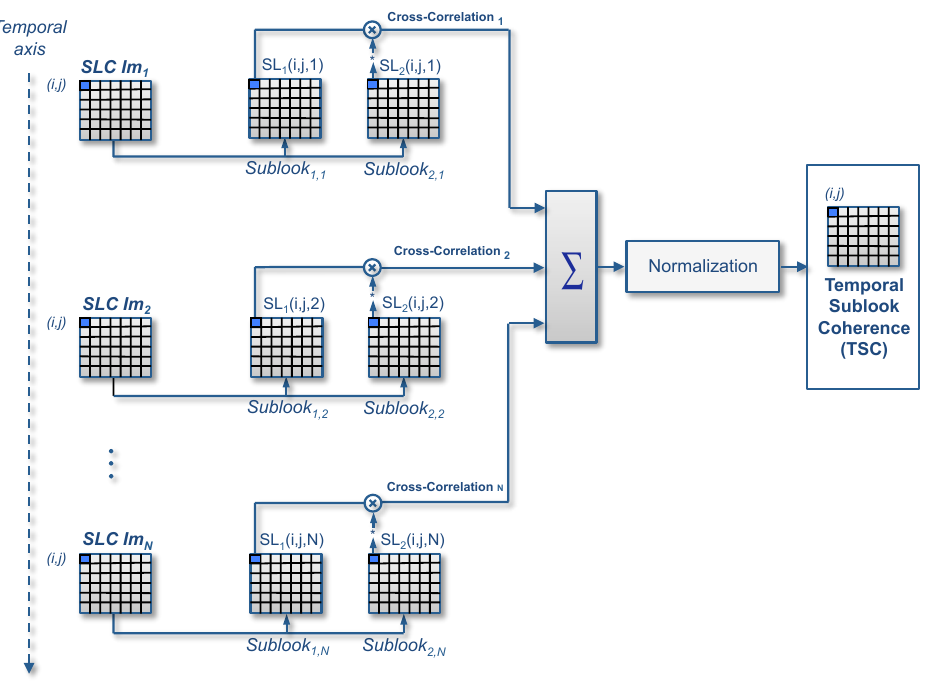
Figure 5. Sketch of the TSC flow chart for a generic pixel ( i, j )